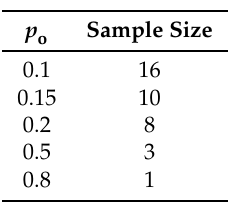
Table 2. Sample size